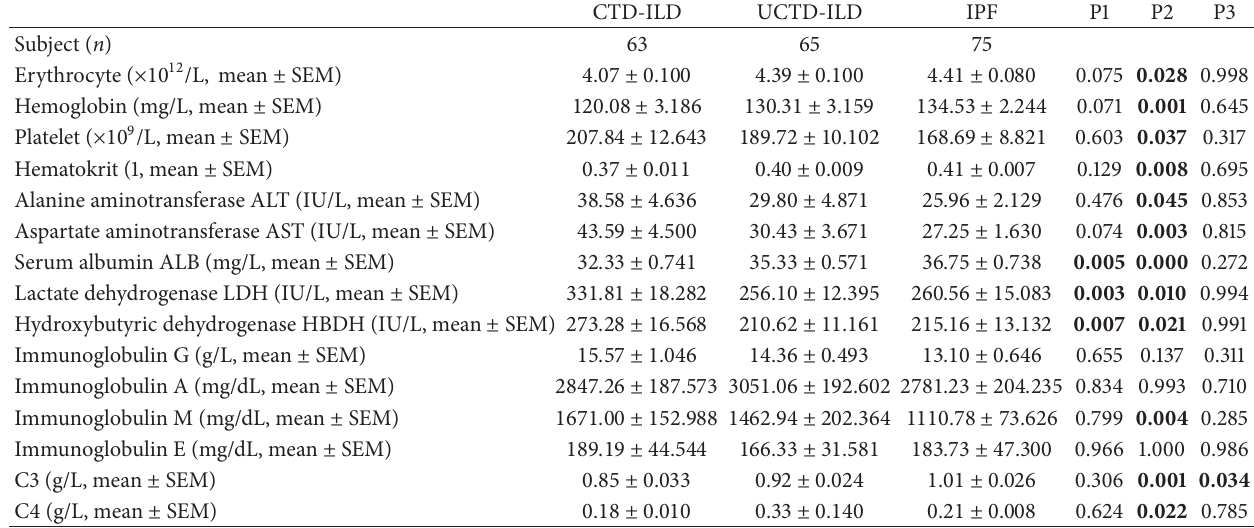
Table 4: Comparison of laboratory findings among CTD-ILD, UCTD-ILD, and IPF patients.